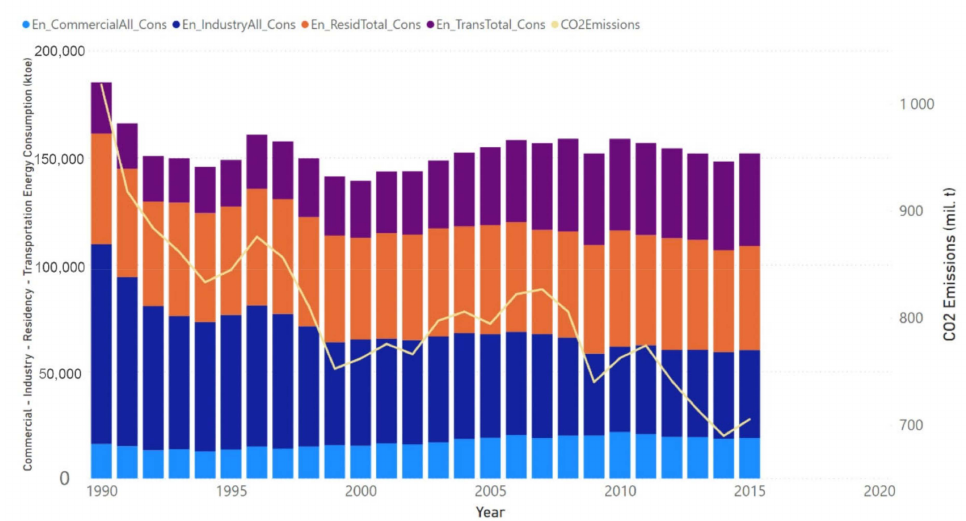
Figure 3. Sectorial Energy Consumption vs. CO 2 emissions time series.